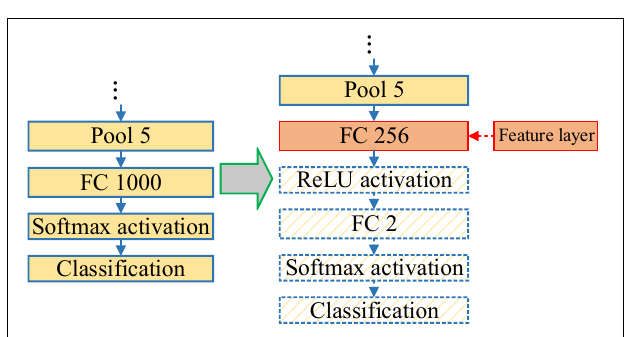
FIGURE 4 | Transfer learning using ResNet-18 (“FC”: fully